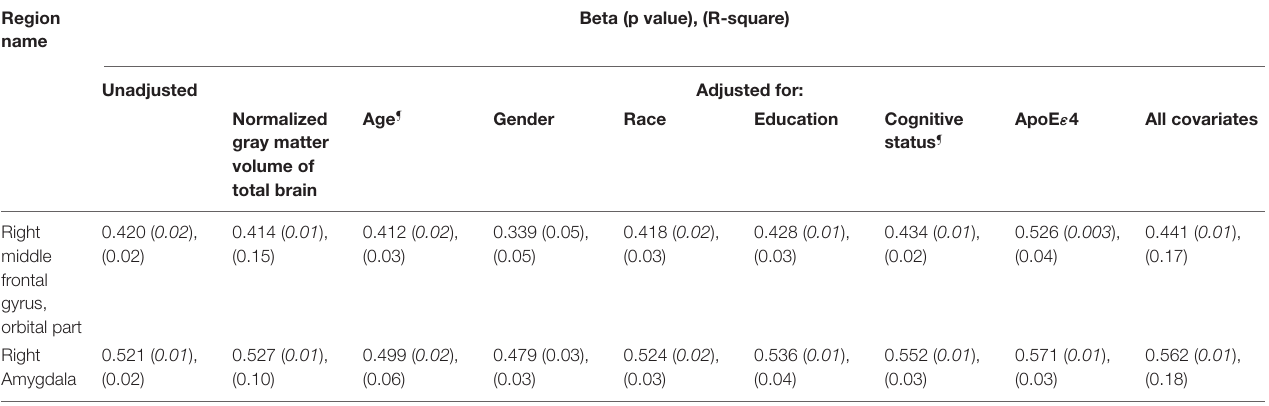
TABLE 3 | Results of multivariable linear regression models showing association of hyposmia in 1998–99 with mean diffusivity of gray matter in 2006–08 in selected regions of interest. Region